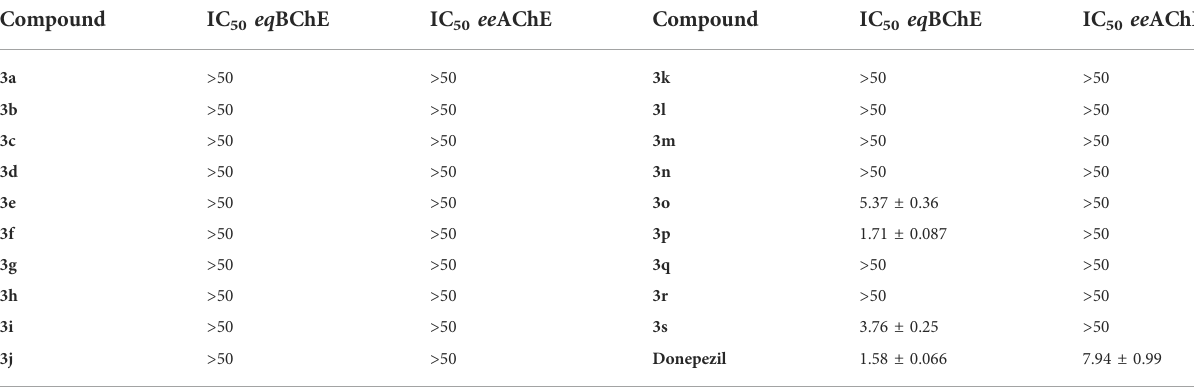
TABLE 1 IC 50 (µM) values of compounds 3a-3s on eq BChE and ee AChE a . Compound